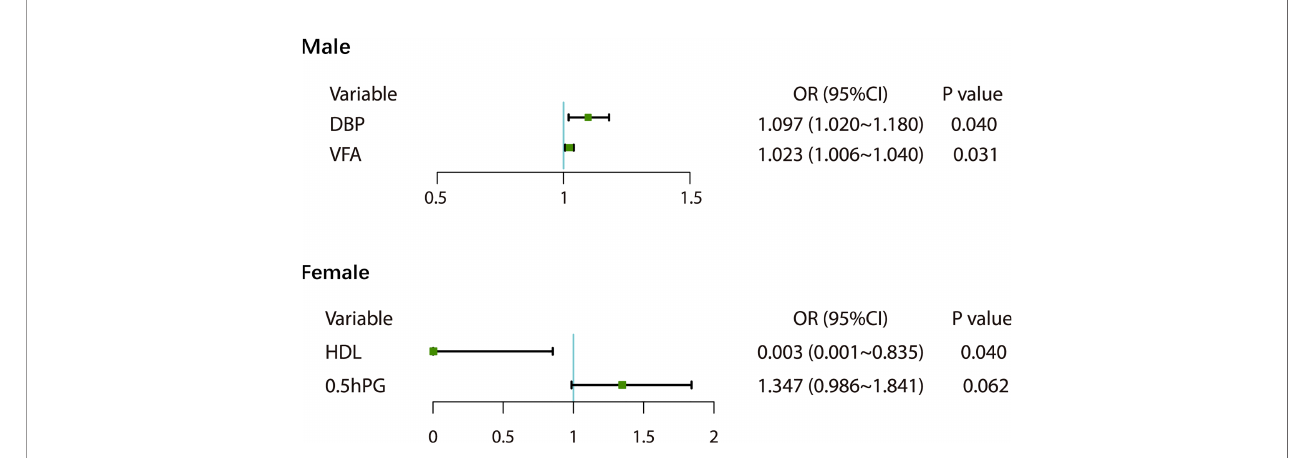
FIGURE 3 | In fl uencing factors of MetS outcomes in males